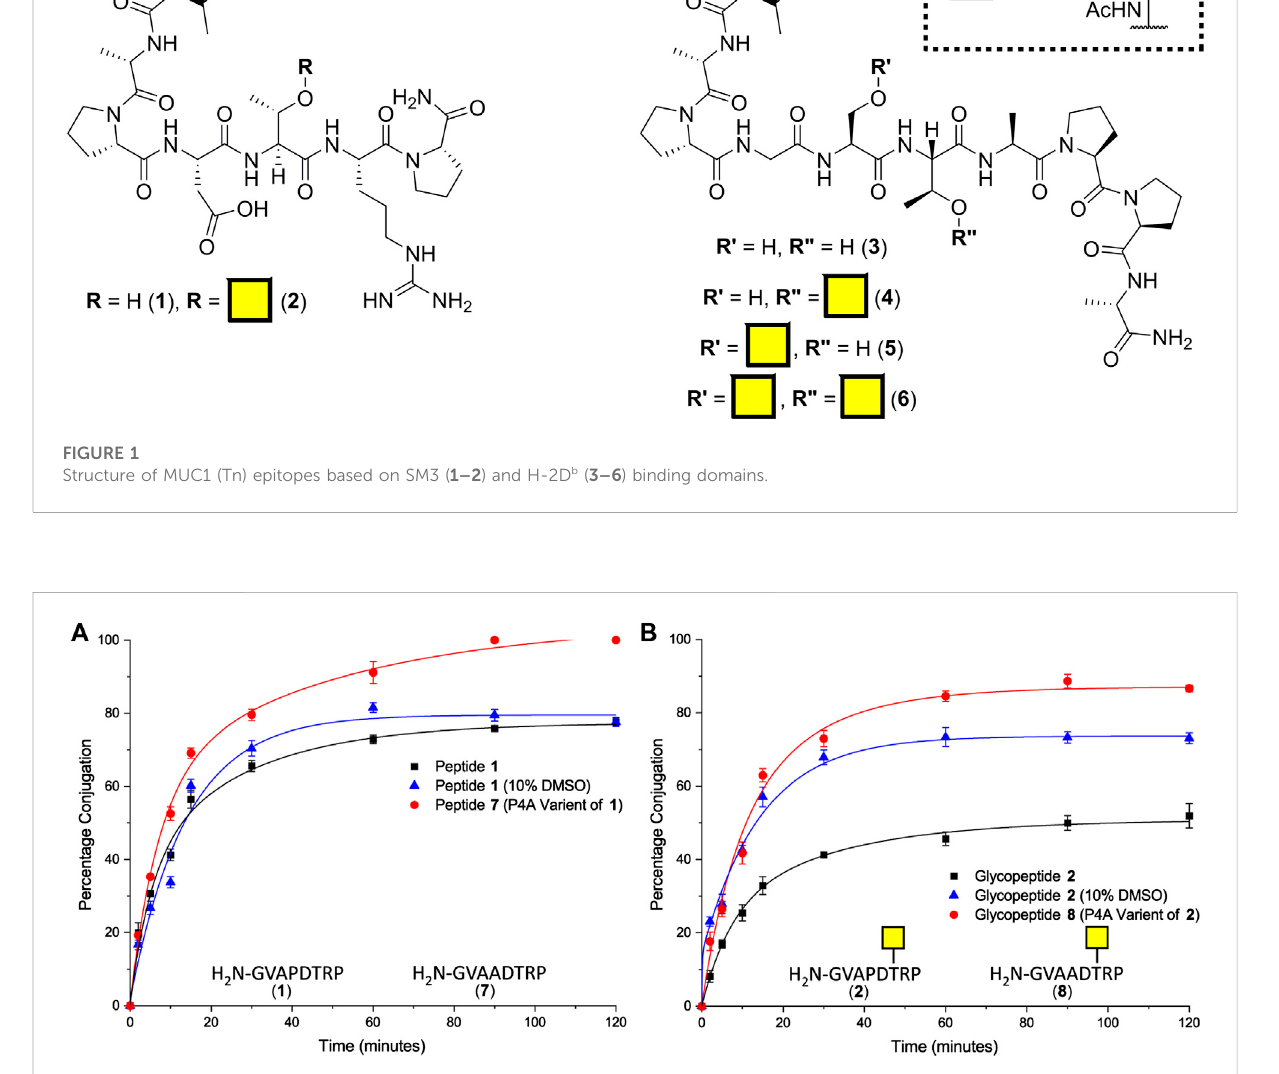
FIGURE 2 (A) Time-course of Sortase 7M – mediated ligation of CTB – LPETGA and peptide 1 based on the SM3 recognition sequence or peptide 7 (P4A variantofpeptide 1 ). (B) Time-courseofSortase7M – mediatedligationofCTB – LPETGAandglycopeptide 2 basedontheSM3recognitionsequence or glycopeptide 8 (P4A variant of glycopeptide 2 ). Percentage conjugation an average of three densitometry measurements and error bars indicate 2 × standard